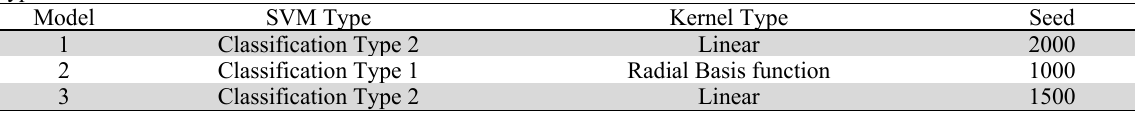
Type of SVM Model